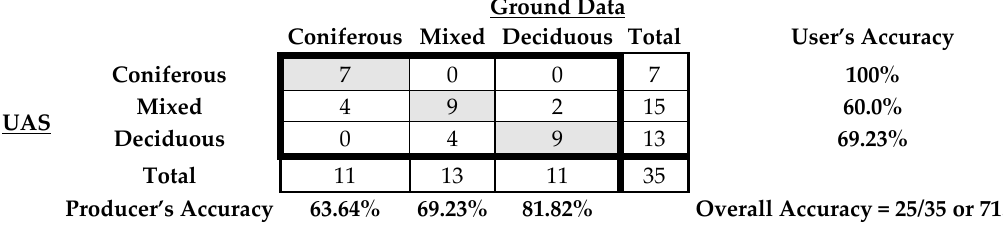
Table 6. OBC sample unit thematic map error matrix for stratified randomly distributed subsamples. Ground (reference) data are represented by the CFI plots and Unmanned Aerial Systems (UAS) data are derived from the corresponding orthomosaic.